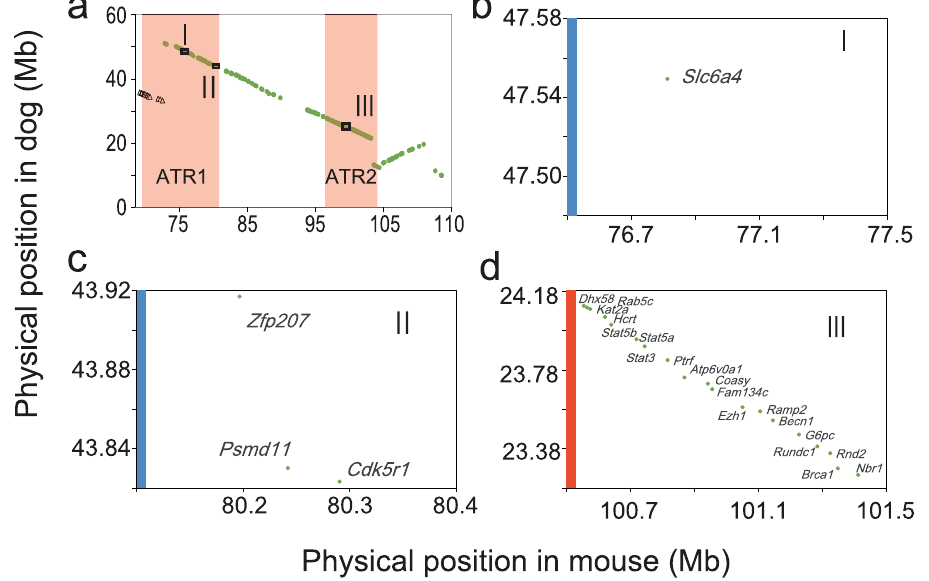
Figure 6. Comparative analysis of the mouse and dog genomes. We performed a comparative analysis of the mouse and dog genomes to determine whether the syntenic region of ATR1 was selected during the domestication of dogs. We first downloaded gene data for orthologues from Ensembl (Archive EnsEMBL release 67; NCBI m37 for mouse and CanFam2.0 for dog). We then used selective sweep datasets that referred to the domesticated region from previous publications18,19. Overlapping genes between the orthologues and the selective sweep regions were then extracted. ( a ) Plot of the genes on mouse chromosome 11 expressed in mouse brain (x-axis) against synteny in dogs (y-axis). Triangles are dog chromosome 5, circles are dog chromosome 9. ( b – d ) Syntenic regions of mouse chromosome 11 in dogs and regions that have been selected during the domestication of dogs, identified by performing genomic comparisons of grey wolves and dogs (vertical blue line) and of 10 domesticated dog breeds (vertical orange